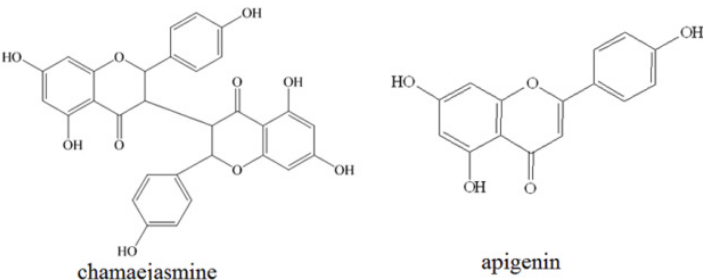
Figure 1. Chemical structure of chamaejasmine and